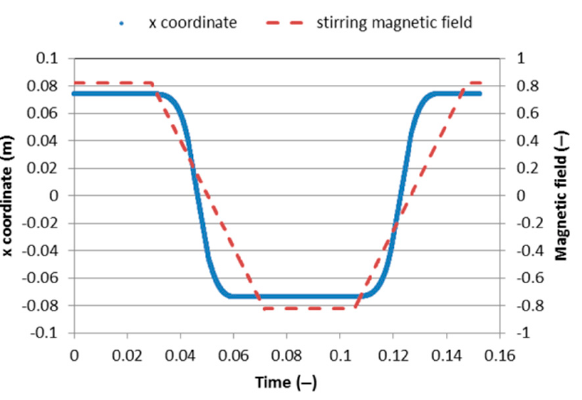
Figure 5. Time evolution during a stirring period of the x-coordinate of the arc component T.